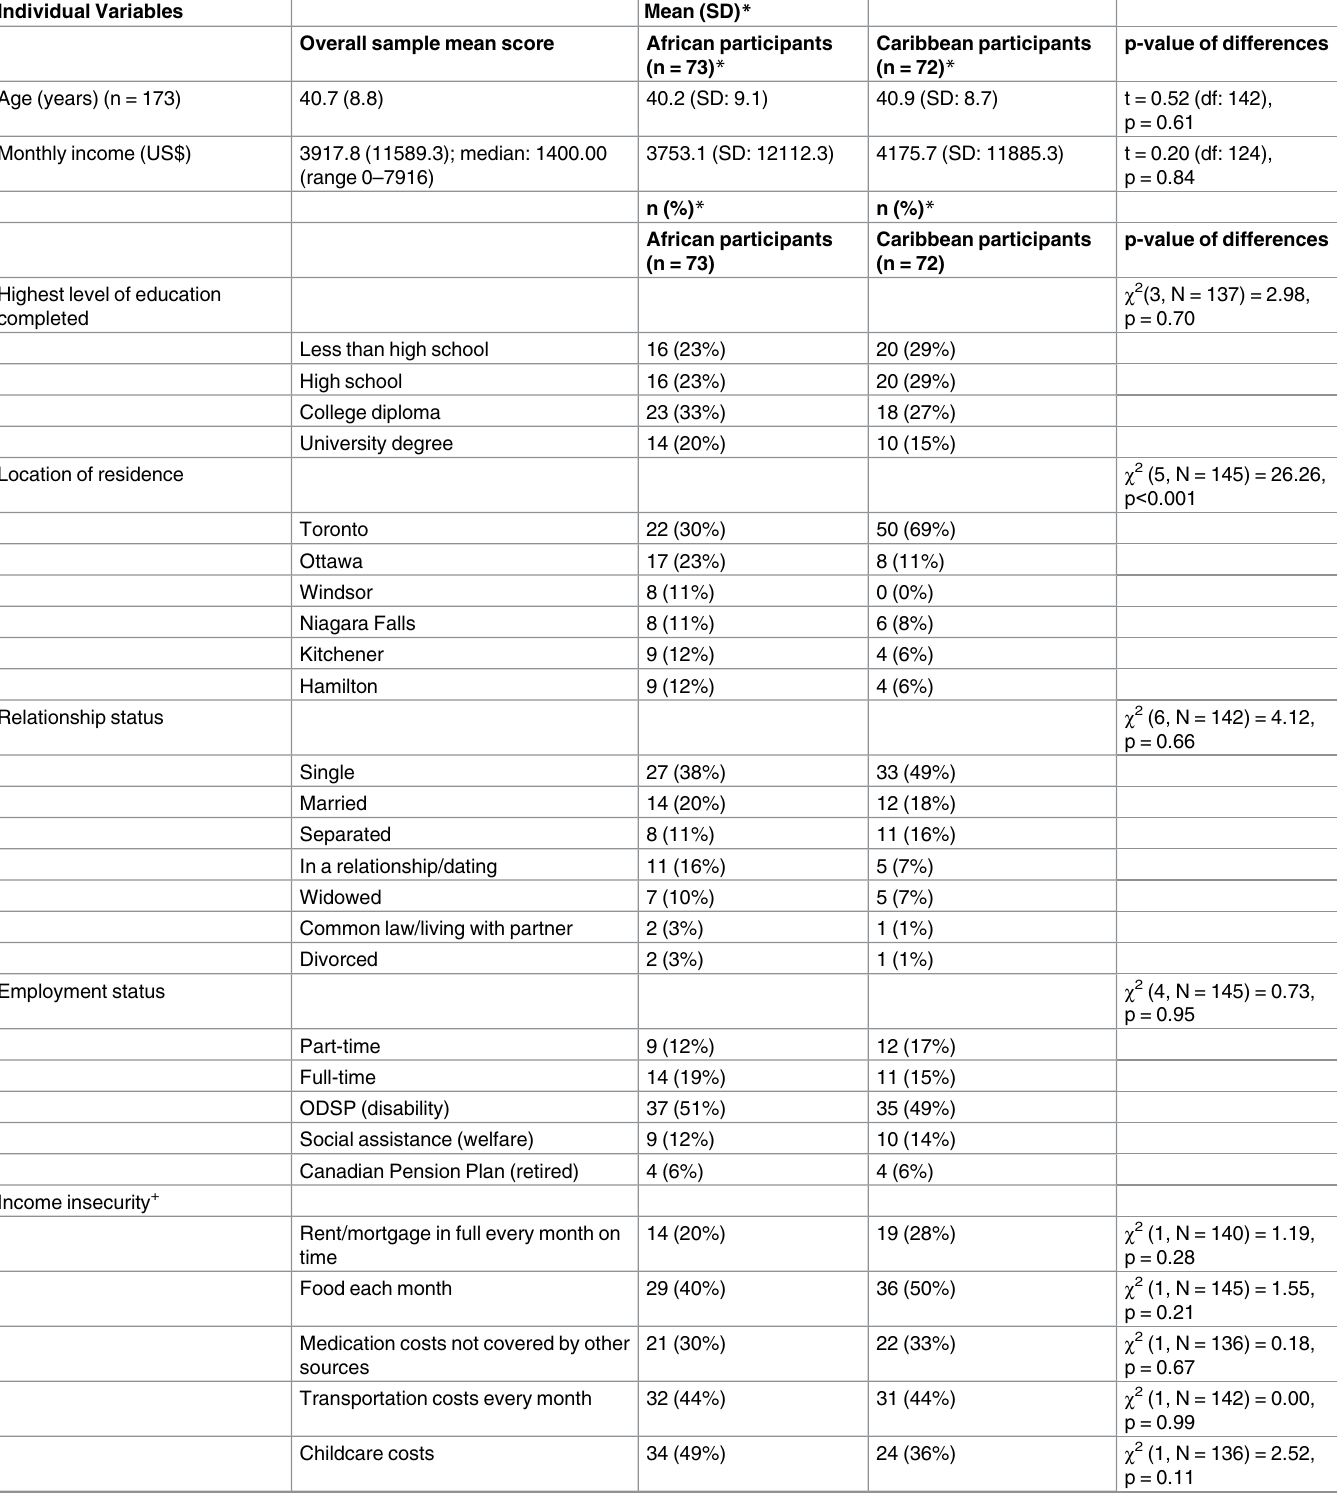
Table 1. Socio-demographic Characteristics of Survey Participants (n = 173) by Ethnicity in the African and Caribbean Black Women’s Stigma and Health Study: Ontario, Canada,